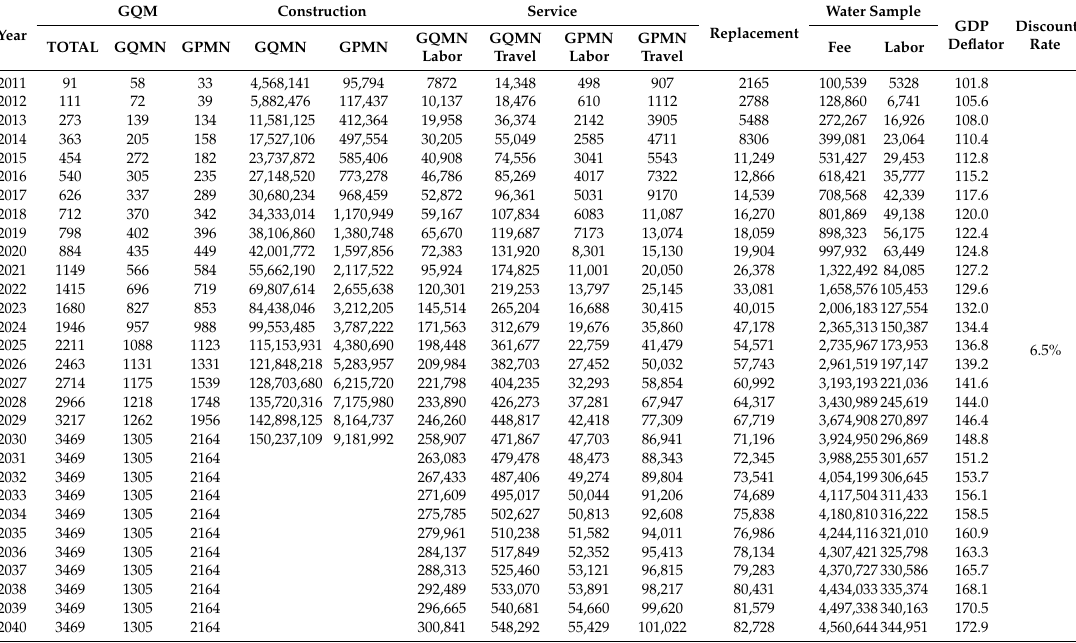
Table A5. Cost detail of the GQM (unit: